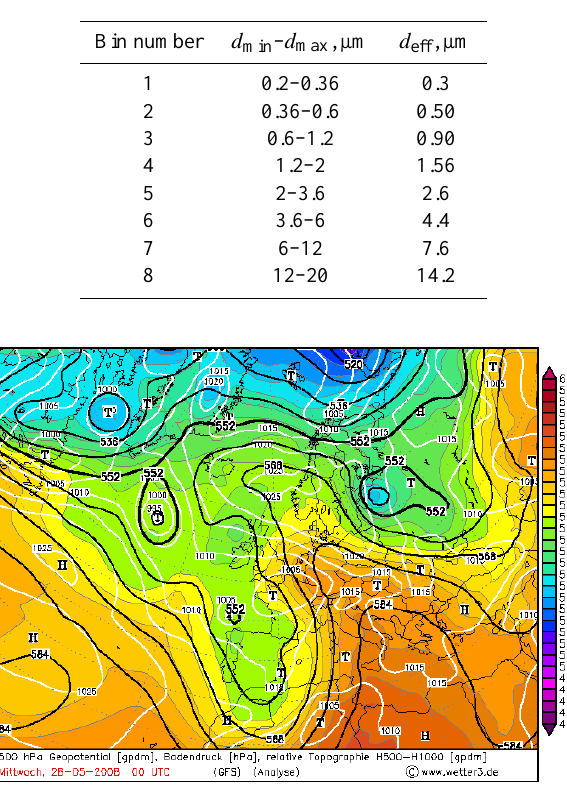
Fig. 1. 500/1000hPa relative topography and surface pressure on 28 May 2008.